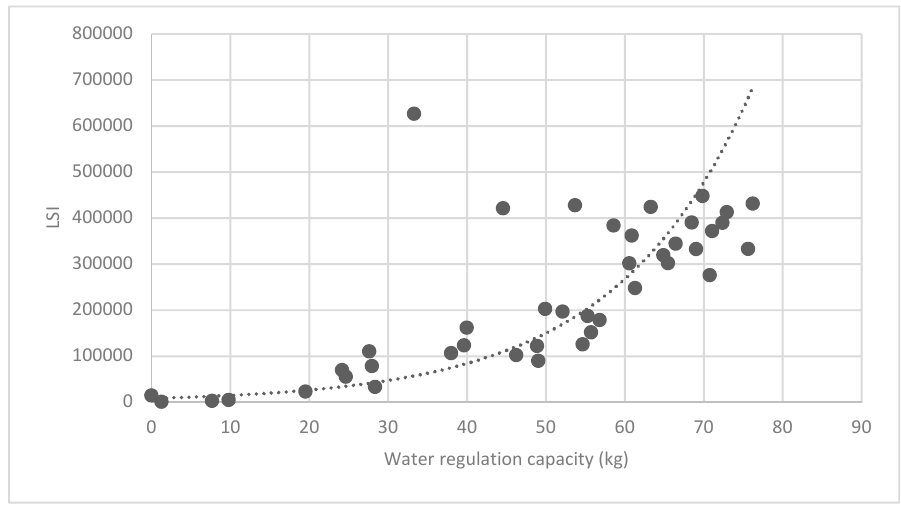
Figure 33. Association between brush LSI and water regulation capacity.